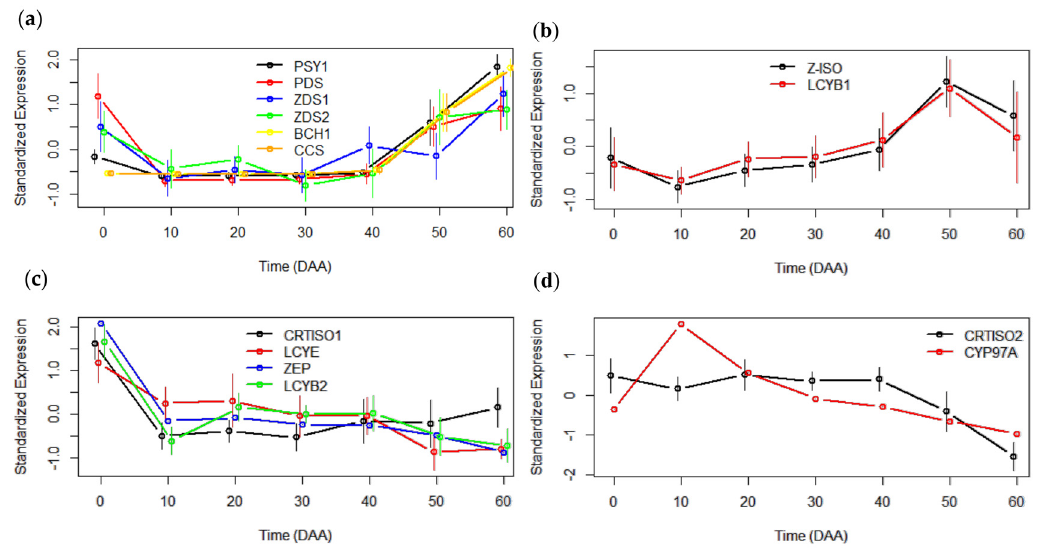
Figure 2. Groups of TGs of carotenoid biosynthesis with similar expression patterns. ( a ) Phytoene synthase ( PSY1 ), phytoene desaturase ( PDS ), Z-carotene desaturase 1 ( ZDS1 ), Z-carotene desat- urase 2 ( ZDS2 ), beta-carotene hydroxylase ( BCH1 ), and capsanthin/capsorubin synthase ( CCS ) ( b ) Z-carotene isomerase ( Z-ISO ) and lycopene beta cyclase 1 ( LCYB1 ) ( c ) lycopene isomerase 1 ( CTRTISO1 ), lycopene epsilon cyclase ( LCYE ), zeaxanthin epoxidase ( ZEP ), and lycopene beta cyclase 2 ( LCYB2 ) ( d ) lycopene isomerase 2 ( CRTISO2 ) and cytochrome P450 97A ( CYP97A ) .